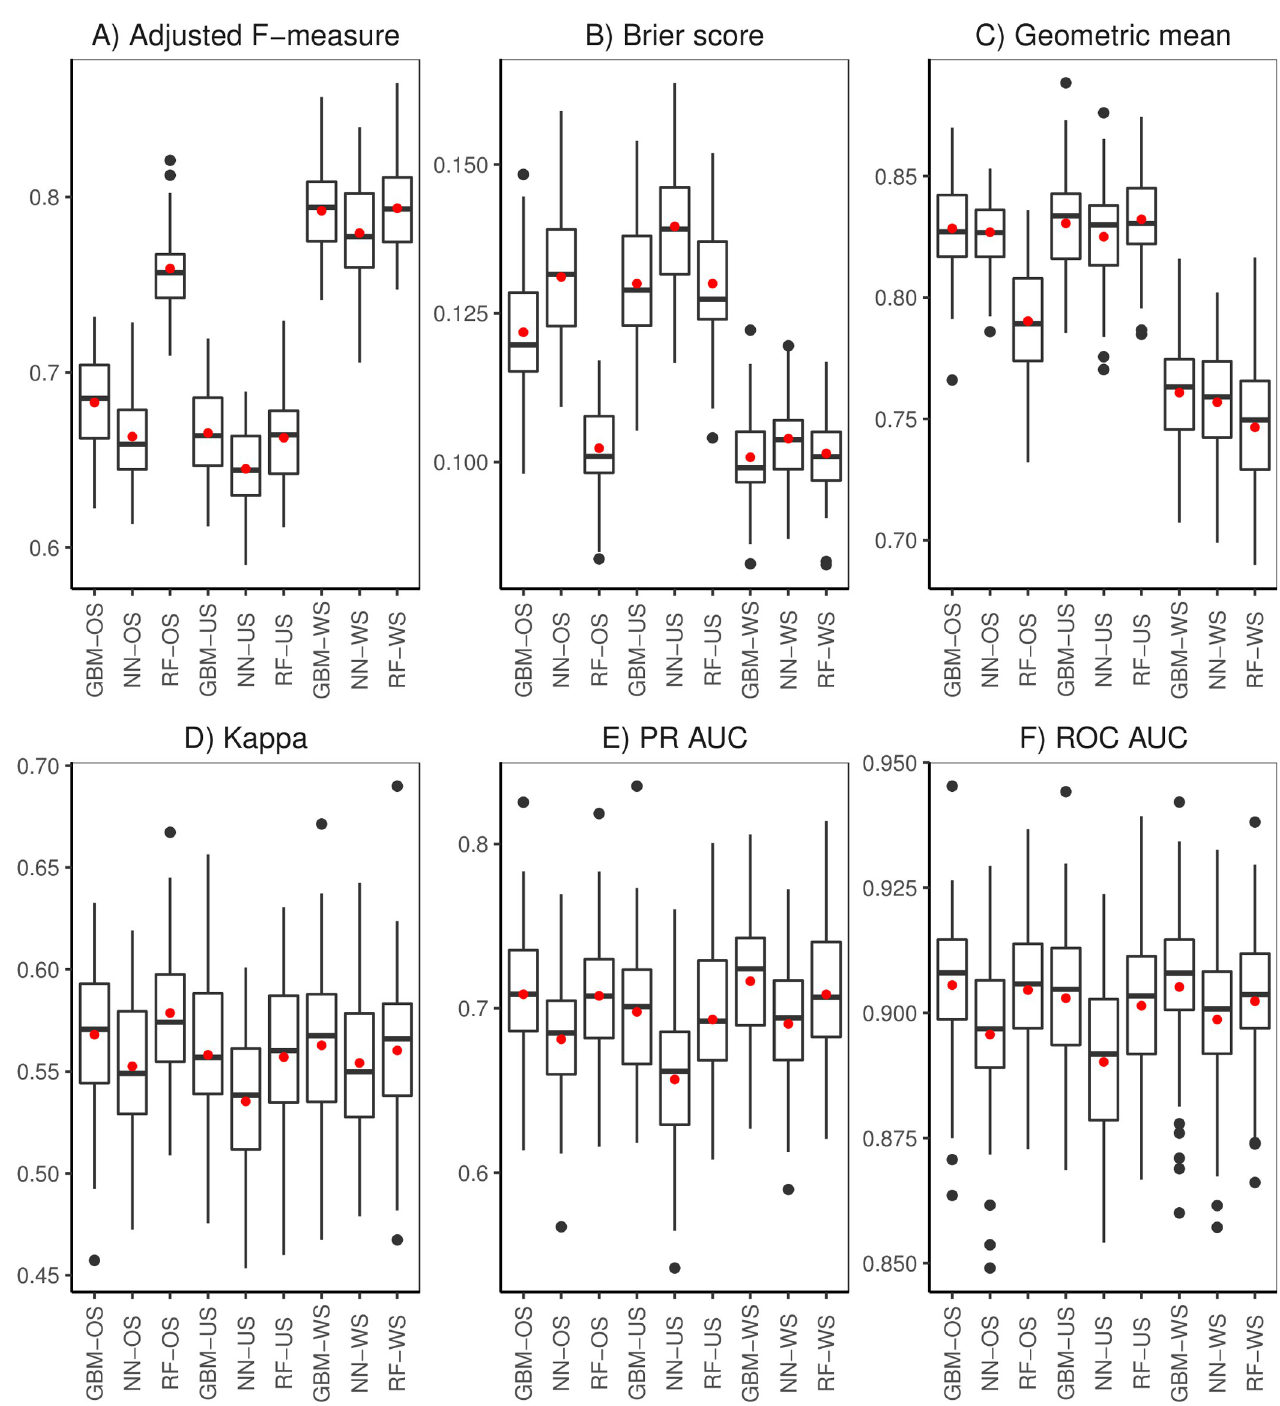
Fig 5. Performance metrics (A: Adjusted F-measure, B: Brier score, C: Geometric mean, D: Cohen’s Kappa, E: PR AUC, F: ROC AUC) for random forest (RF), gradient boosted machines (GBM) and neural networks (NN) trained on the 17 covariates selected using recursive feature elimination. Each algorithm was trained under three different sampling scenarios: Oversampling (OS), undersampling (US) and without sampling (WS). The black line and red dot inside the box are the median and mean, respectively.